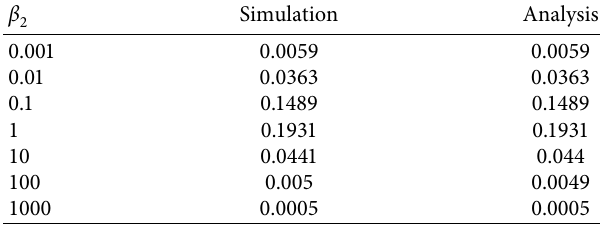
Table 2: Data of instantaneous error versus β